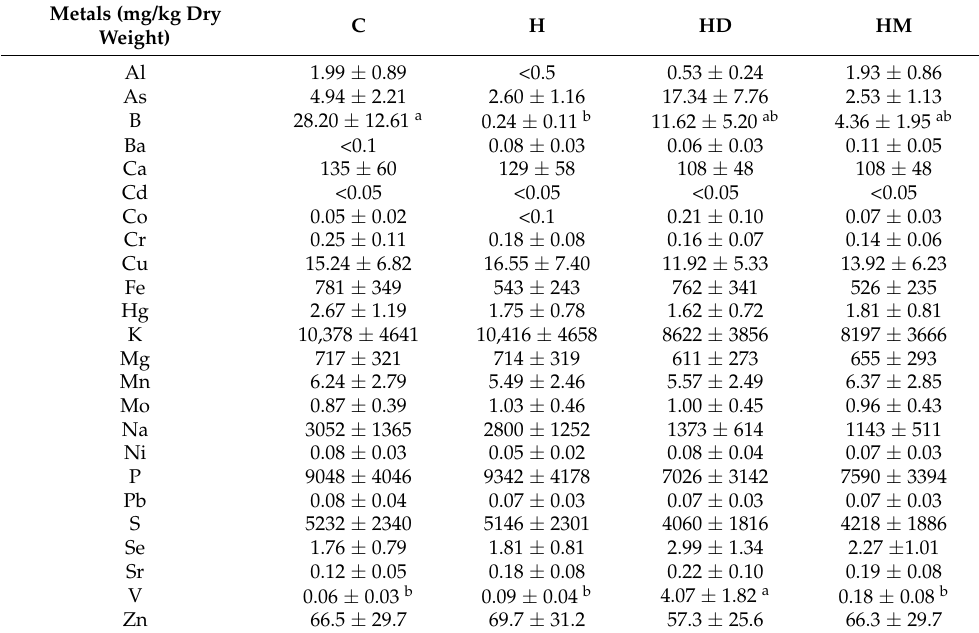
Table 3. Effects of Oedogonium grown in ash dam water and treated municipal wastewater on metal composition in the